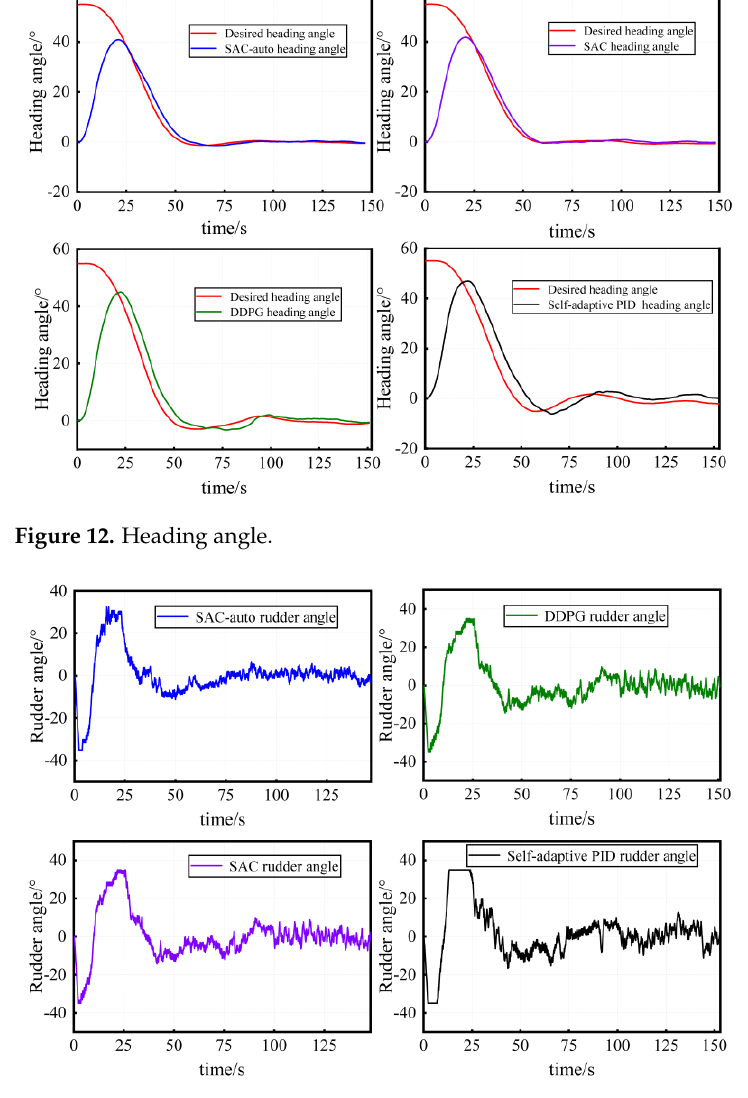
Figure 13. Rudder Angle. Table 5. Data comparison table of four algorithms.